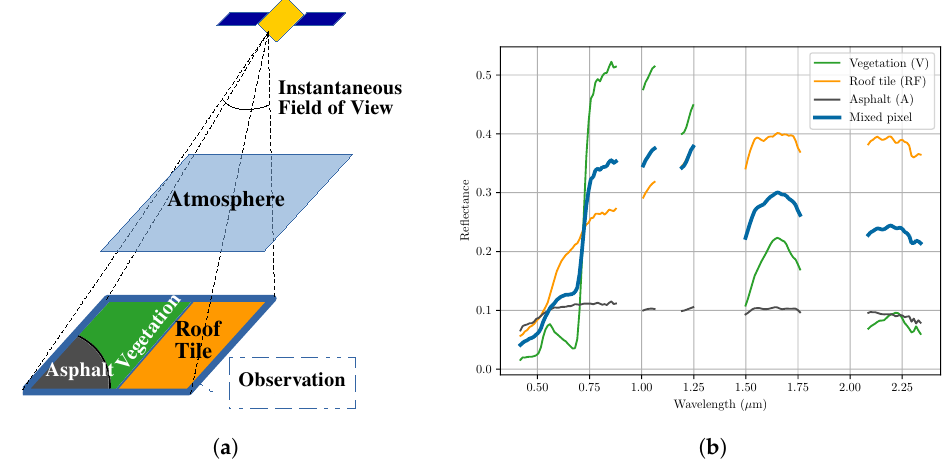
Figure 1. Example of a mixed pixel: ( a ) sketch of a mixed pixel projected at ground level and composed of three materials: asphalt, vegetation, and tile; ( b ) spectral signatures of each material and the equivalent spectral reflectance of the